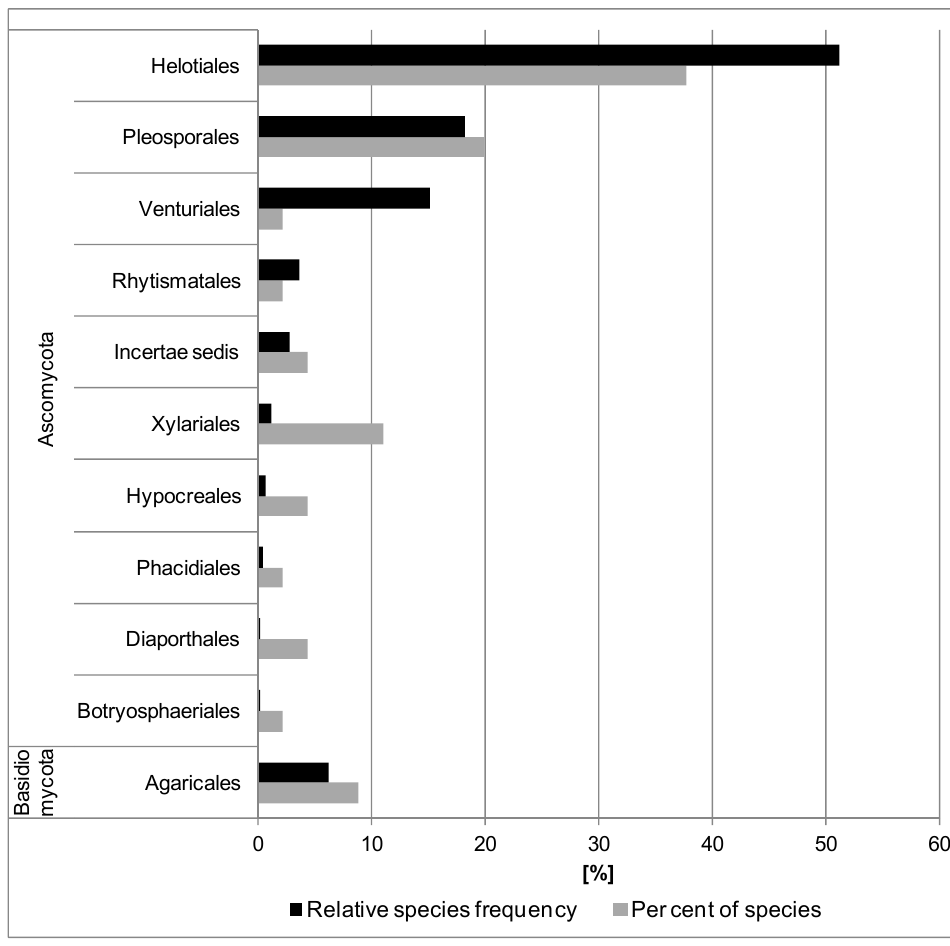
Figure 5. Frequency of fungi detected in situ from fruit bodies on the previous year’s leaf petioles of F. excelsior . Relative species frequency calculated as the ratio of the number of specimens in the order to all specimens n = 882. Percent of species calculated as the ratio of the number of species in the order to all species n = 45.